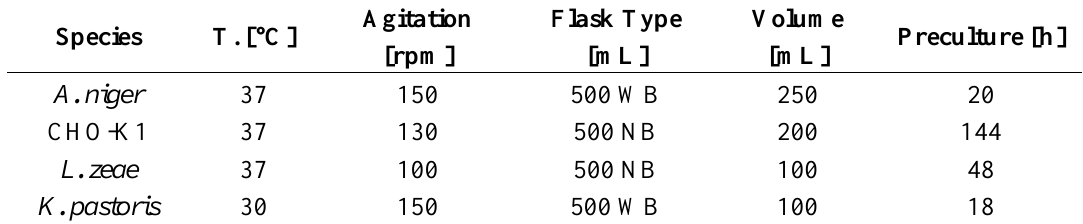
Table 2. Cultivation parameters used for the sensor